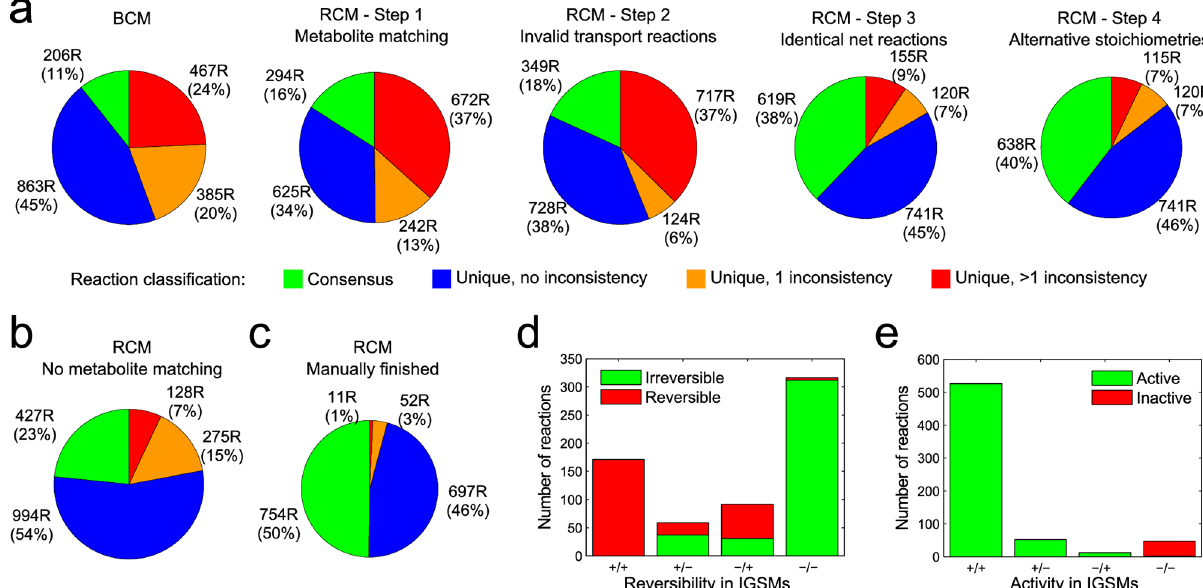
Fig 3. Application of COMMGEN to P . putida GSMs. ( a ) Automatic inconsistency identification and reconciliation substantially increases consensus and reduces inconsistencies. Reactions are classified into consensus reactions (green) and unique reactions involving no (blue), a single (orange), or multiple (red) inconsistencies. ( b, c ) Characteristics of the refined consensus model as in ( a ) without network- based metabolite matching ( b ), or after manually addressing the remaining inconsistencies ( c ). ( d ) Numbers of reversible ( ‘ + ’ ) and irreversible ( ‘ - ‘ ) reactions in the RCM, grouped by the four possible combinations of reversibilities in the IGSMs. ( e ) Numbers of active and inactive reactions in the RCM, grouped by being active ( ‘ + ’ ) or inactive ( ‘ - ‘ ) in the IGSMs.